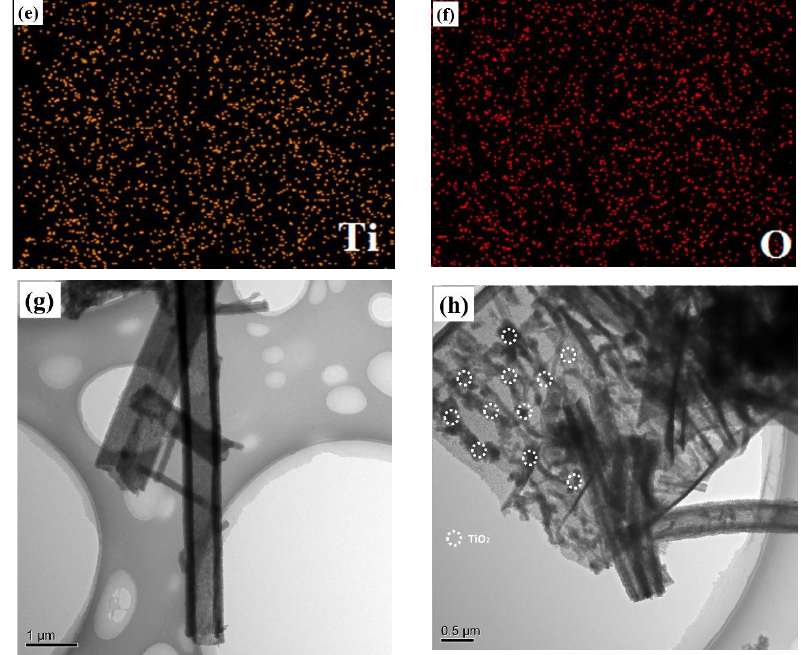
Figure 2. ( a , b ) SEM image, ( c – f ) EDS elemental mapping and ( g , h ) TEM image of the as-prepared samples.